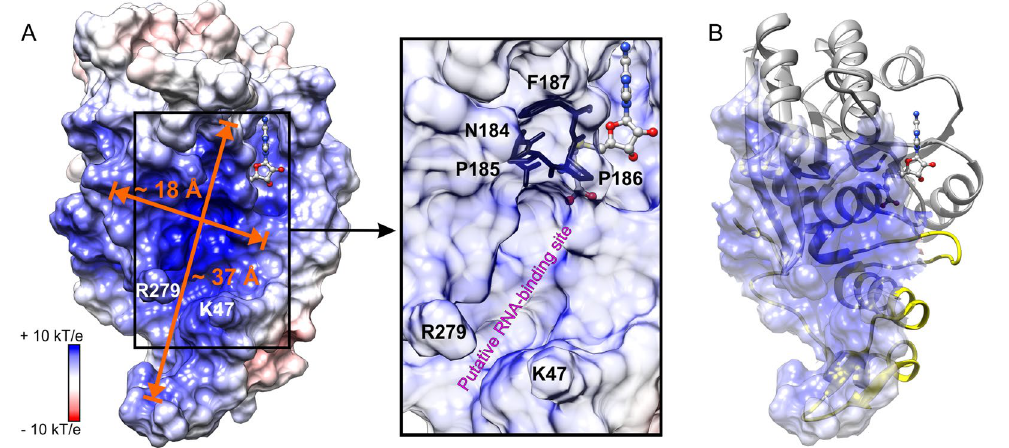
Figure 3. Putative RNA-binding site in METTL16_291. ( A ) Surface electrostatic potential is shown for the METTL16_291/SAH complex. Groove dimensions and claw-forming residues, K47 and R279, are marked and SAH is a ball-and-stick model. The box shows a close-up view of the conserved catalytic residues, 184 NPPF 187 , located between the putative RNA-binding site and SAH-binding pocket under semi-transparent surface. ( B ) Overall fold of METTL16_291 with semi-transparent representation of positively charged groove surface. Gray and yellow colors are as defined in Fig.